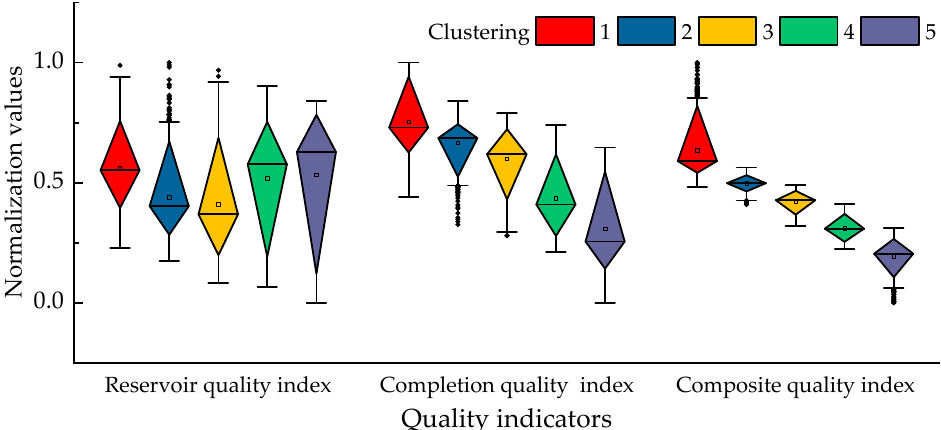
Figure 7. Boxplot of the composite quality evaluation index for well A.